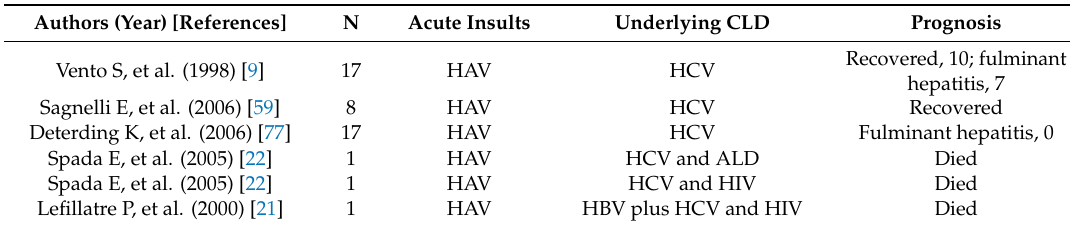
Table 4. Acute-on-chronic liver failure (ACLF) and / or the superinfection of hepatitis virus (HAV) in patients with hepatitis C virus